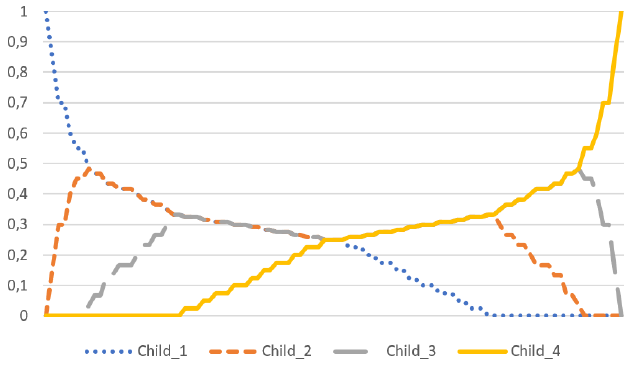
Figure 7. Weighted Diamond: the probability per child state, given the ordening of the parents states on the x-axes.